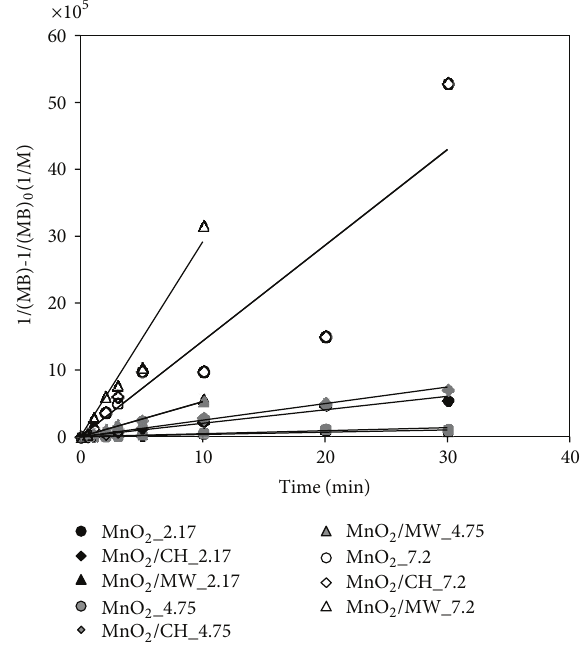
F 4: Plot of 1/[AMO] versus time for AMO degradation, [MnO slope and correlation coefficient of regression line are displayed in 2 Table 3.